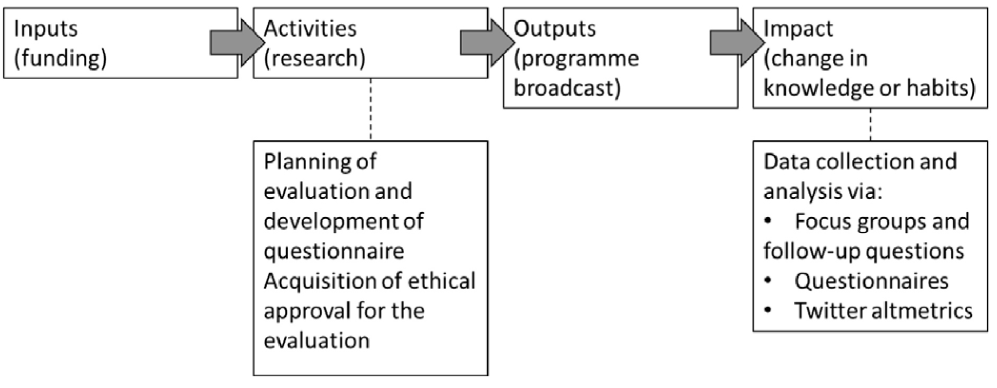
Figure 1: Logic model and points where activities are required – some data collection may also need to occur before broadcast, for acquisition of baseline knowledge, for